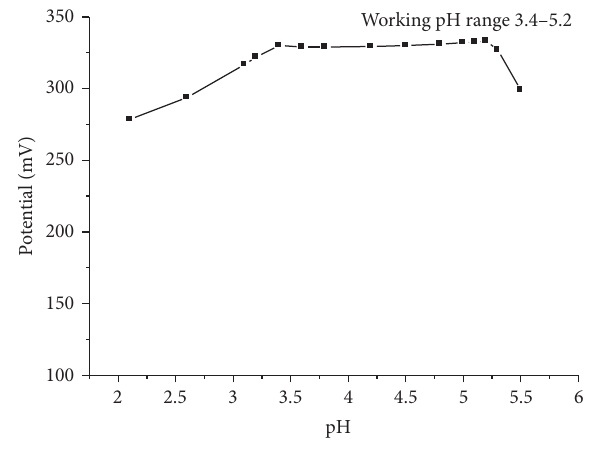
F 2: Effect of pH on the cell potential of electrode.